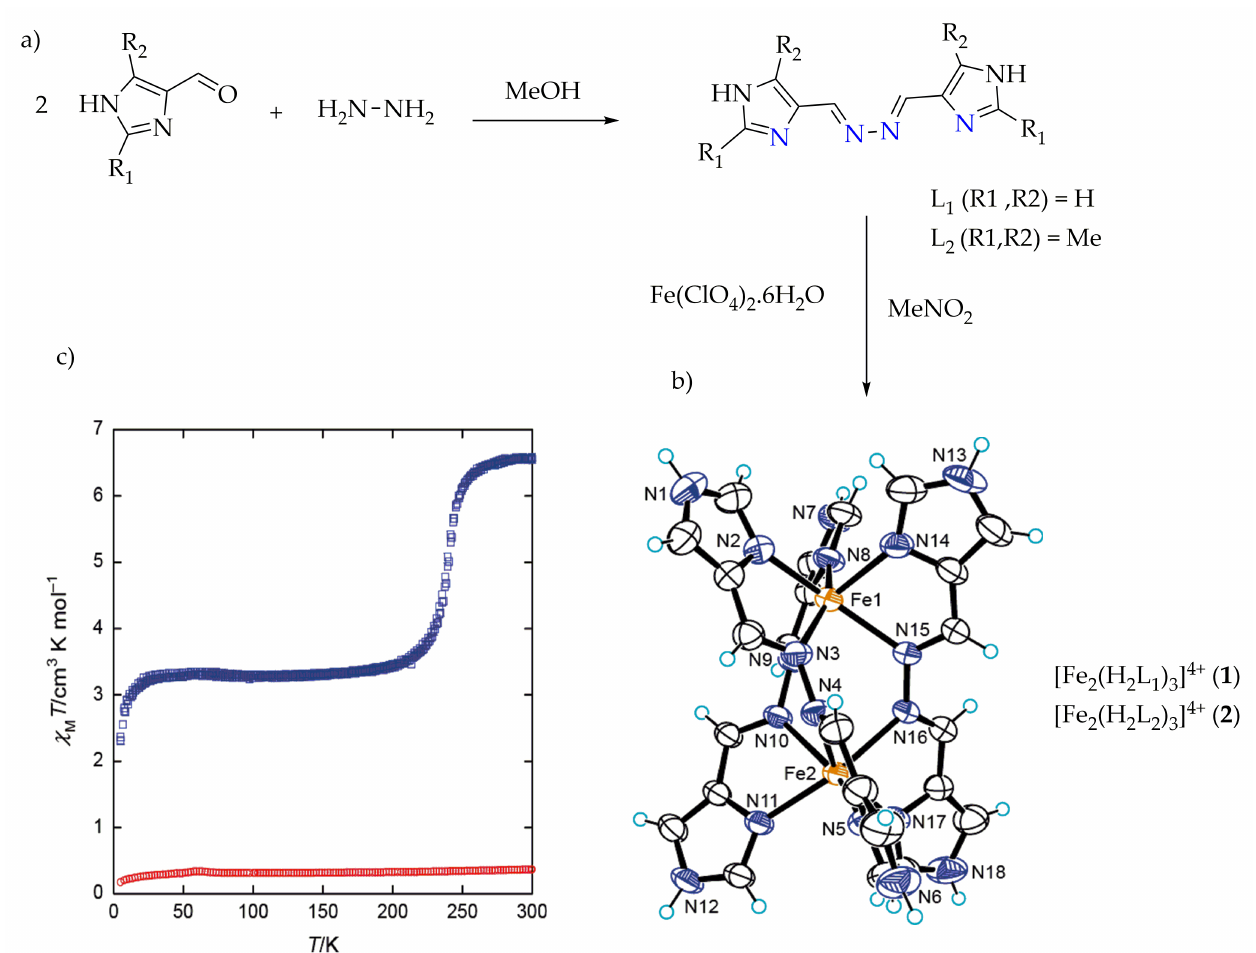
Figure 4. ( a ) L 1 and L 2 used to synthesize spiral iron(II) complexes. ( b ) X-ray molecular structure of the cation of complexes ( 1 ) and ( 2 ). Color code: orange = Fe; blue = N; black = C; light blue = H. ( c ) Magnetic behaviors of complex ( 1 ), (blue) and ( 2 ) (red) in the form of a χ M T vs. T plot. Reproduced with permission from [59]; Published by American Chemical Society,